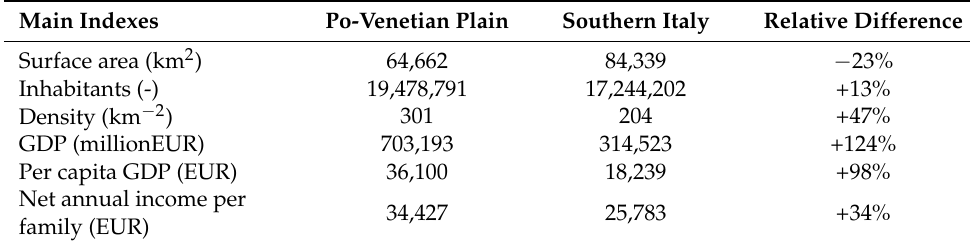
Table 3. Main demographic, social, and demographic indexes for the case study